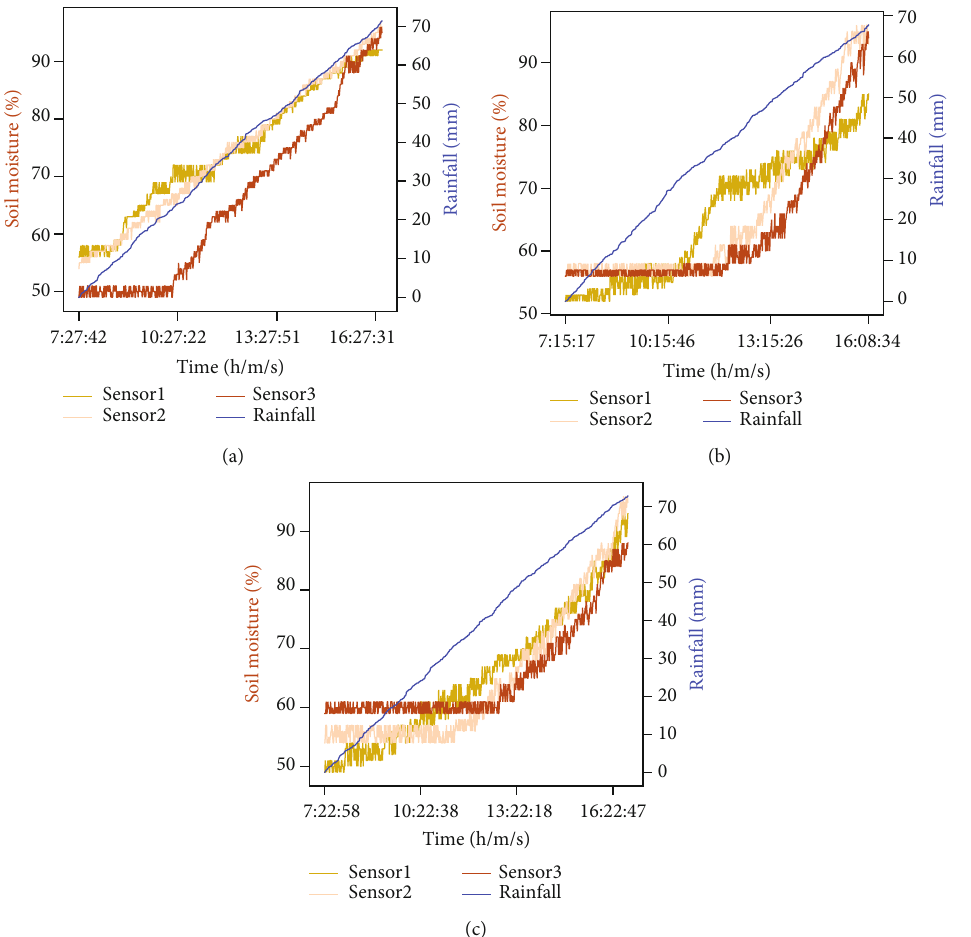
Figure 7: Variation of soil moisture content versus cumulative rainfall for three experimental tests on site SD2. The slope failure was observed for the fi rst two tests (a, b) and did not occur during the last test